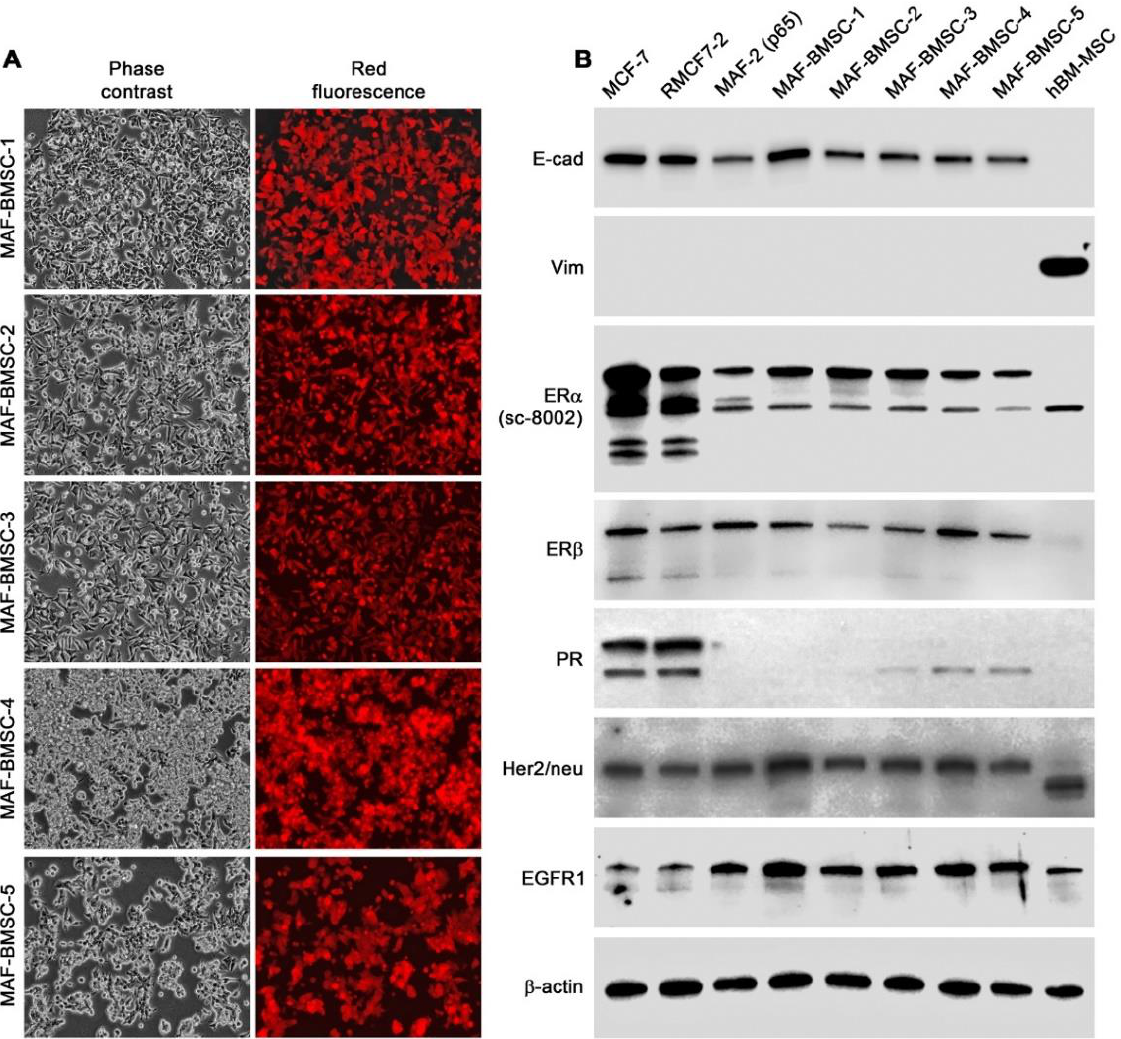
Figure 6. Morphology and marker protein expression of clones isolated from the second round of co-culture. Characteristics of the first five MAF-BMSC-clones are shown. ( A ) Diversified morphology and growth behavior of the clones at passage 30 (40×). ( B ) The clones at p60 still maintained the pattern of marker expression of the parental MAF-2 clone (compared to Figure 4C).